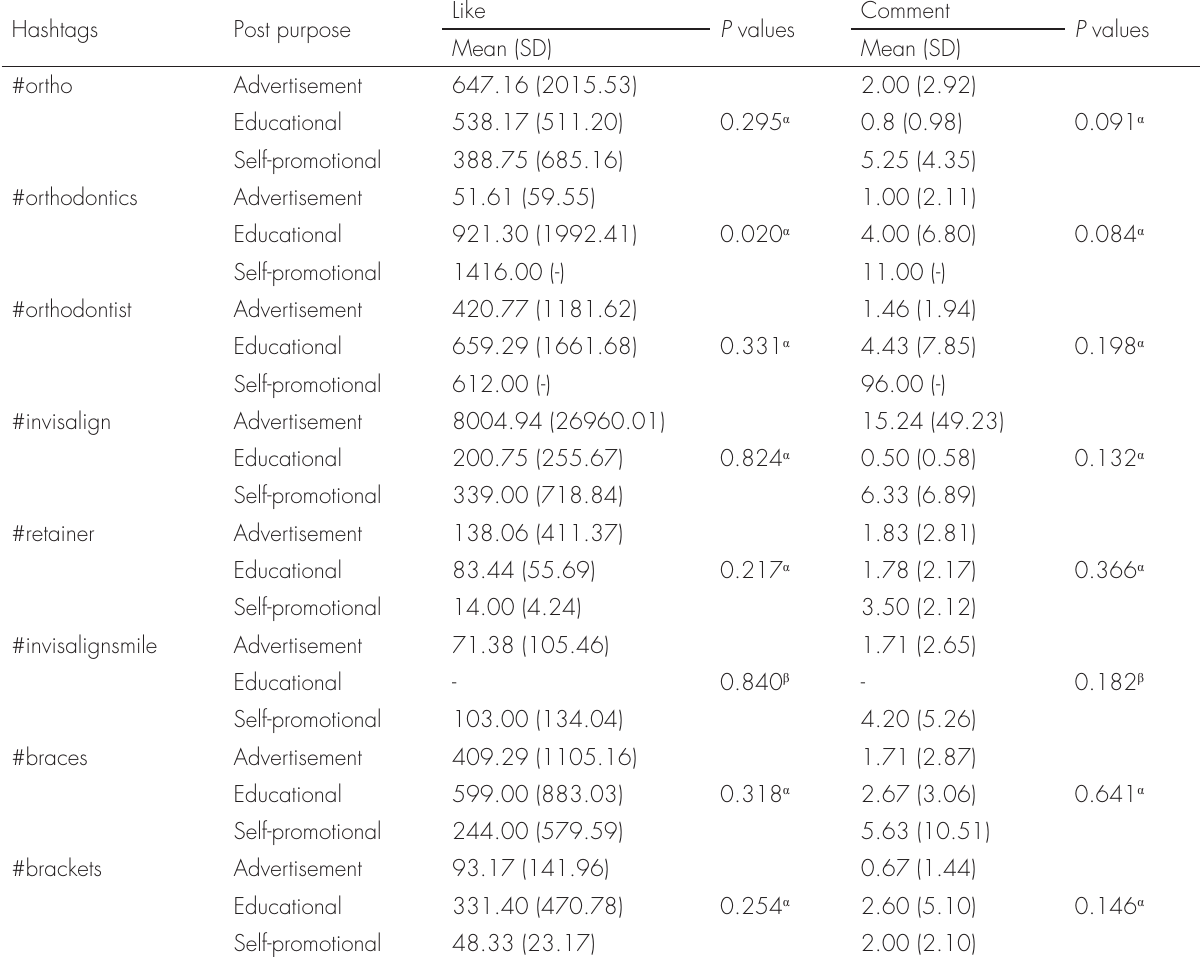
Table IV. Comparison of hashtag number of ‘likes’ and comments according to post